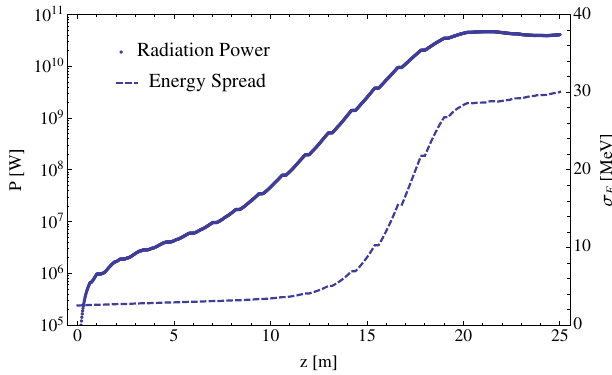
FIG. 2. SASE power and energy spread upstream of the self- seeding